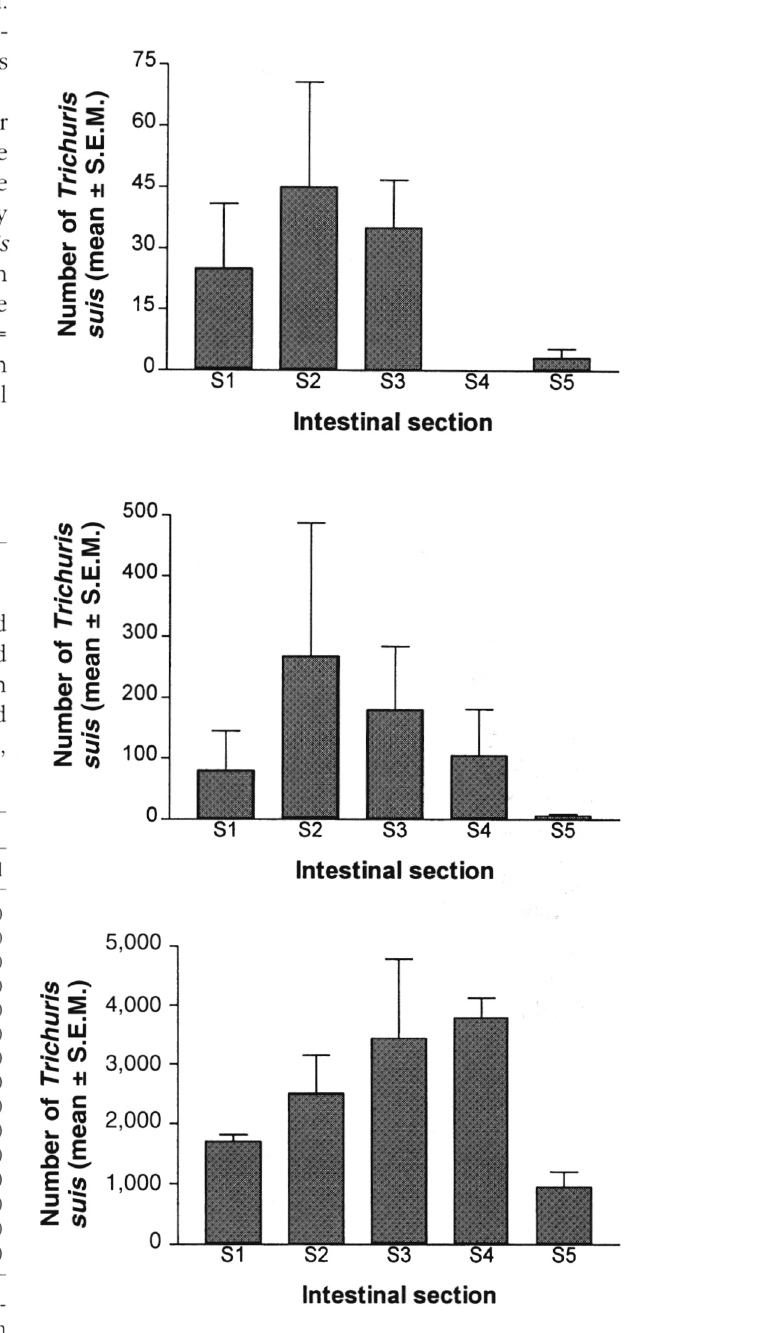
Fig.l. — Mean (± S.E.M.) number of T. suis recovered from five intes­ tinal sections of the A) low, B) medium and C) high dose group, respectively. S1: caecum. S2: 0- 20 % of the total length of colon. S3: 21-40 %. S4: 41-60 %. S5: 61-100 % including rectum. Only T. suis positive pigs are